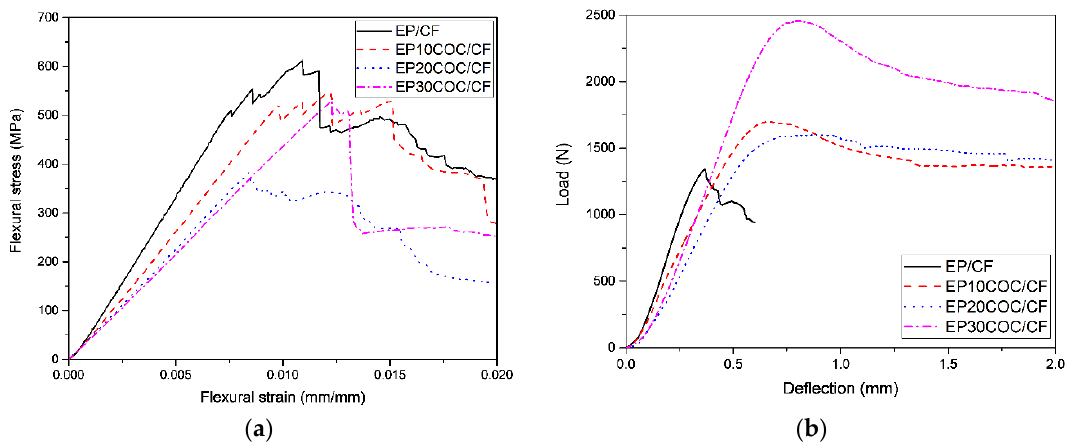
Figure 5. Mechanical tests on the prepared composite laminates. ( a ) Representative flexural stress–strain curves, ( b ) load-deflection curves from short-beam shear tests. Table 3. Flexural properties and interlaminar shear strength (ILSS ) values of the prepared composites. Composite